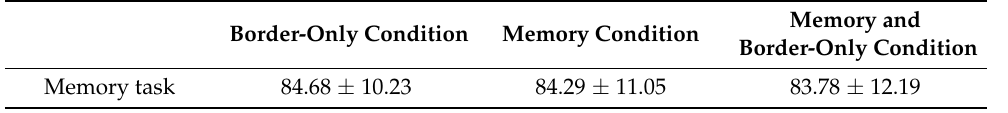
Table 2. Search and memory task performance accuracy (%) (M ±